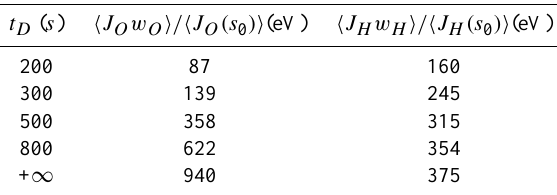
Table 1. Values of the transferred power per unit area and flux from the source (at 1000km) from waves to O + and H + ions, as a function of t